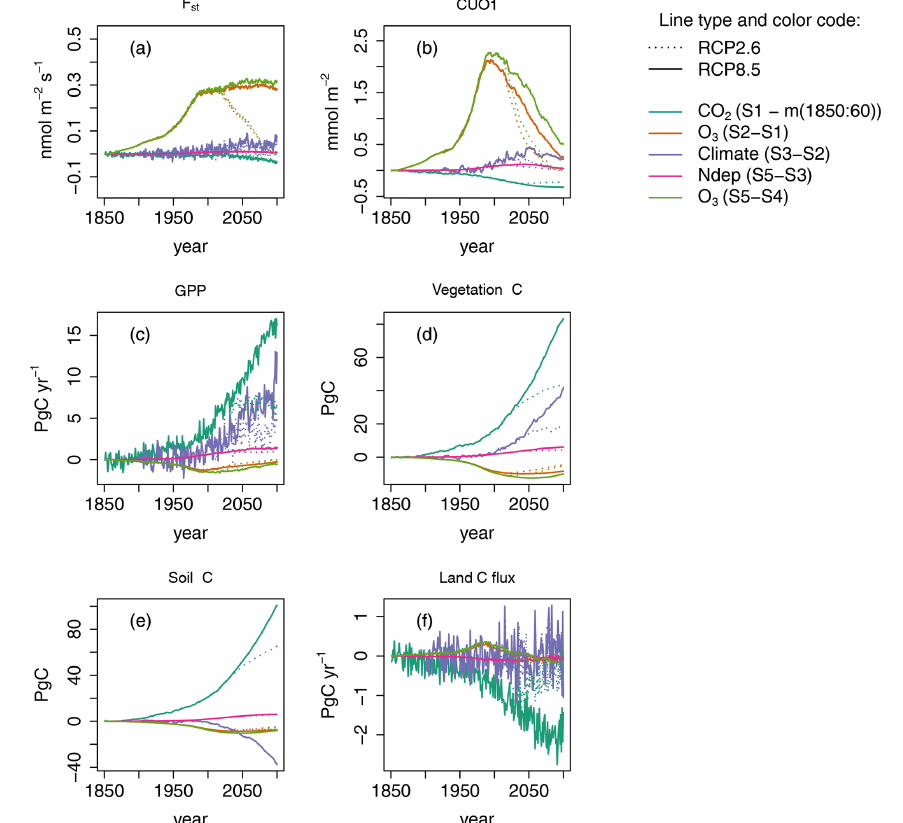
Figure 4. Single drivers obtained by subtracting factorial runs for selected output variables. Displayed are the results for simulated regional mean O 3 uptake ( F st ), regional mean cumulative canopy O 3 uptake above a flux threshold of 1nmolm − 2 s − 1 (CUO1), regional summed GPP, regional summed stocks of total carbon biomass (vegetation C), soil organic matter carbon (soil C), and summed land carbon flux (land C flux) for simulations based on RCP2.6 and RCP8.5. The effect of the seasonal cycle is smoothed by the application of a moving average of 12 months (a, b)